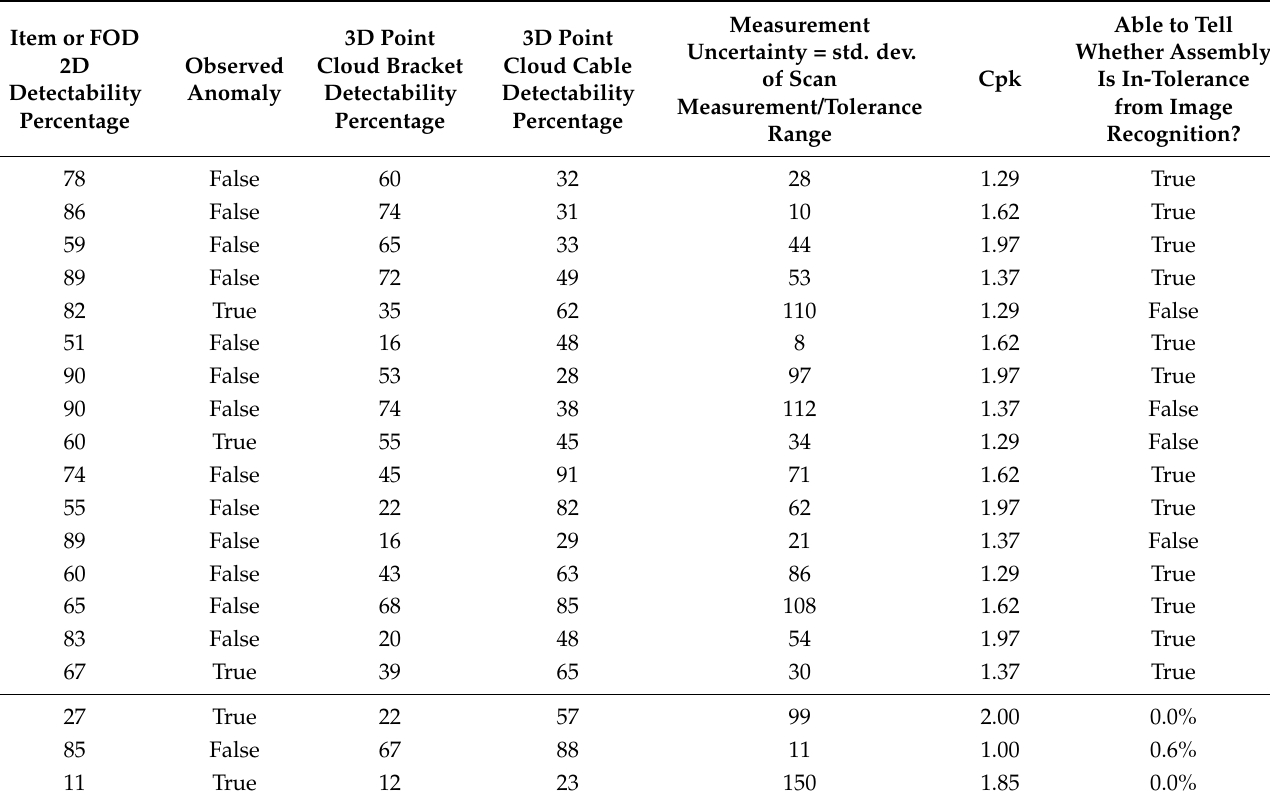
Table 2. Data generated by random simulation for the case study, modified from